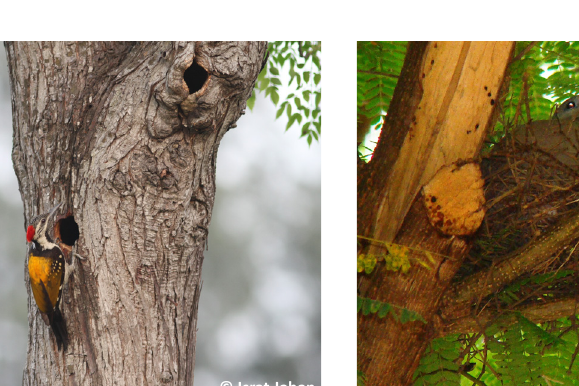
Image 8. Black Drongo